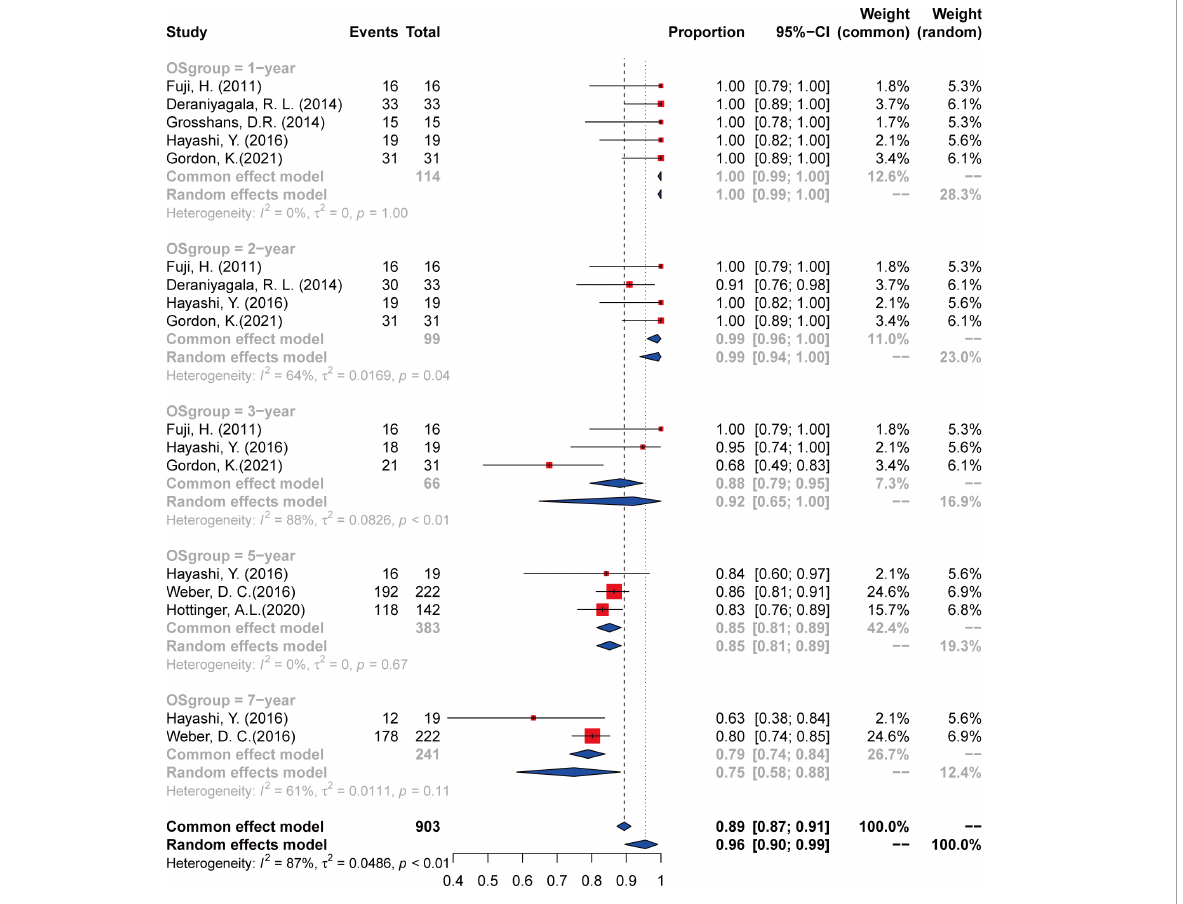
FIGURE 3 The overall survival of chordoma and chondrosarcoma treated with